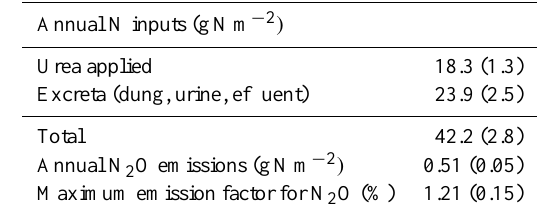
Table 4. Nitrogen budget terms for the IFR site for the year 17 Au- gust 2012 to 16 August 2013. The N 2 O emissions value is from the combined GGR and NSR methods, but with a larger uncertainty es- timate to account for method discrepancy and potential spatial vari- ability across the irrigated circle. The resulting emission factor is considered a “maximum” because the measured emissions include naturally occurring background